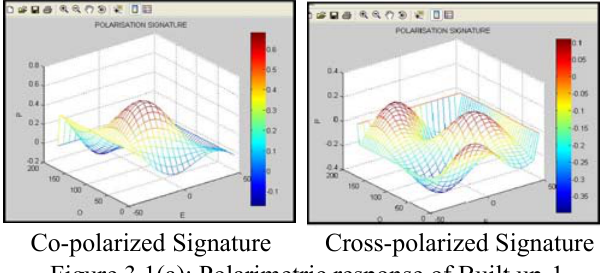
Figure 3.1(a): Polarimetric response of Built up-1 (within city)